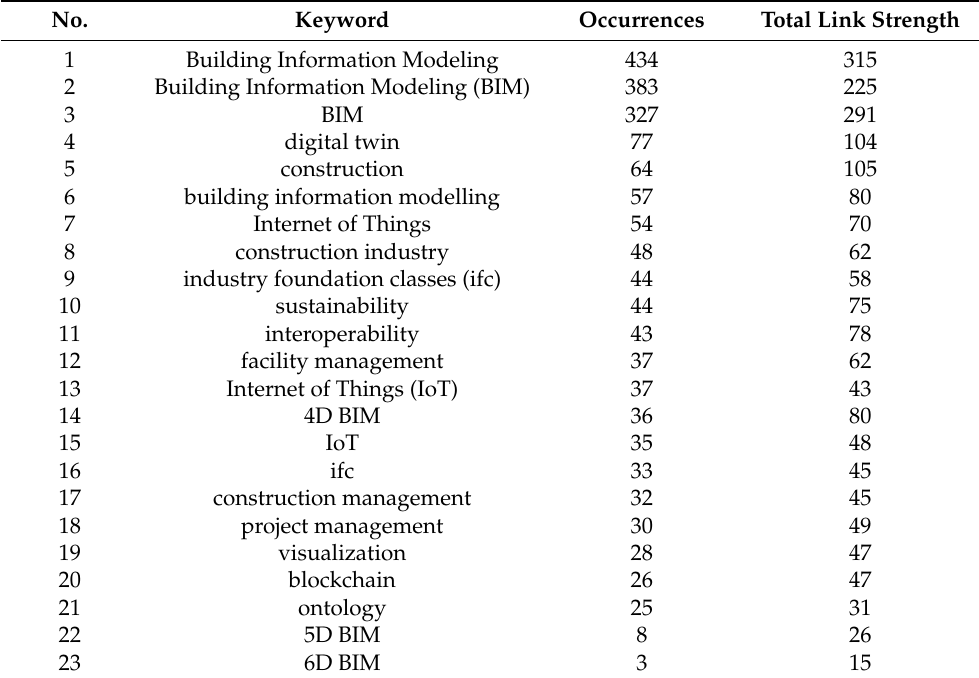
Figure 8. Network of keywords co-occurrence. Table 5. The most prominent keywords in this study.